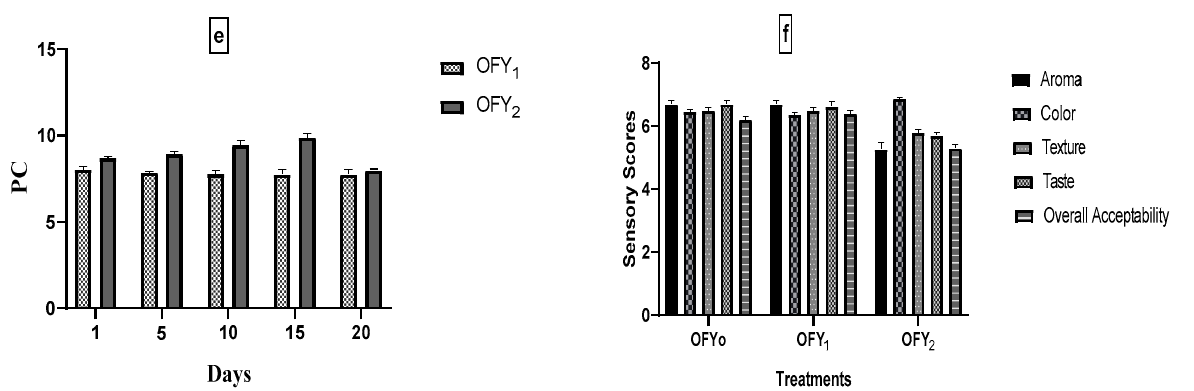
Figure 4. ( a ) Total phenolic contents, ( b ) DPPH activity, ( c ) ABTS activity, ( d ) total viable count, ( e ) probiotic, and ( f ) sensory evaluation of different yogurt treatments. Results are expressed as mean with standard deviation bar.